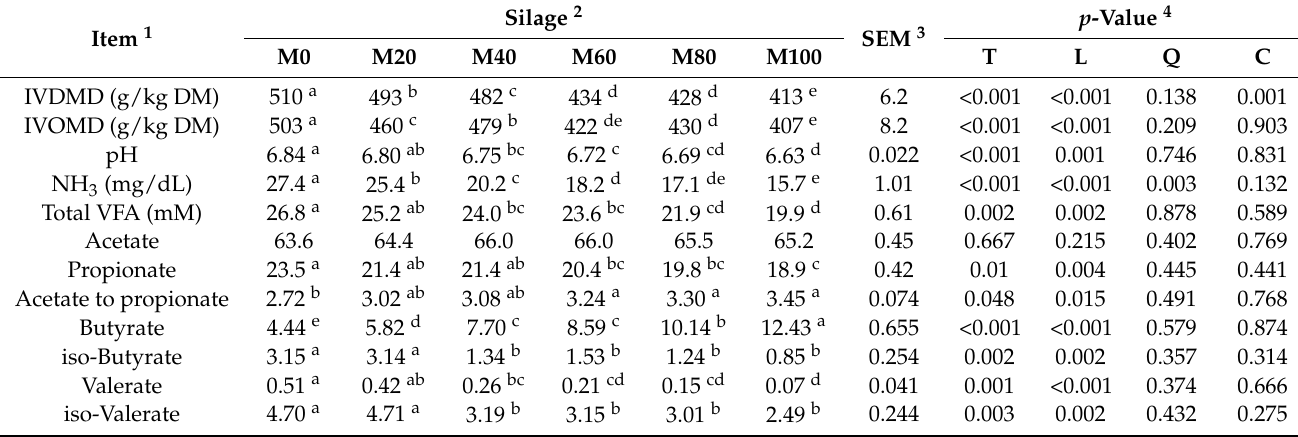
Table 4. In vitro dry matter and organic matter degradability, rumen pH, ammonia, and volatile fatty acid of rumen- incubated silage prepared with lucerne, sweet maize stalk, and their mixtures after 24 h of incubation ( n = 3).